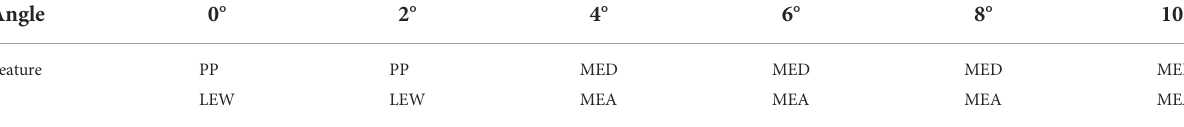
TABLE 1 The features of which the CPDs obviously differ for sea ice and sea water at six small incidence angles. Angle